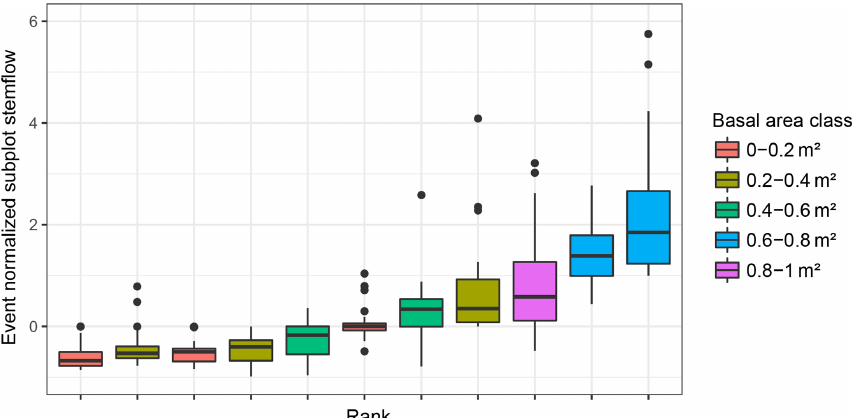
Figure 7. Temporal stability of 100m 2 subplot stemflow over all sampled events. Subplots are ranked according to their median event normalized stemflow and coloured according to basal